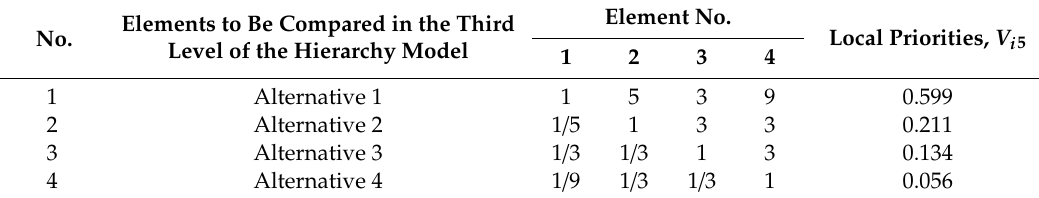
Table10. Matrixofpairwisecomparisonsfortheelementsofthethirdlevelbythecriteria“depreciation”.